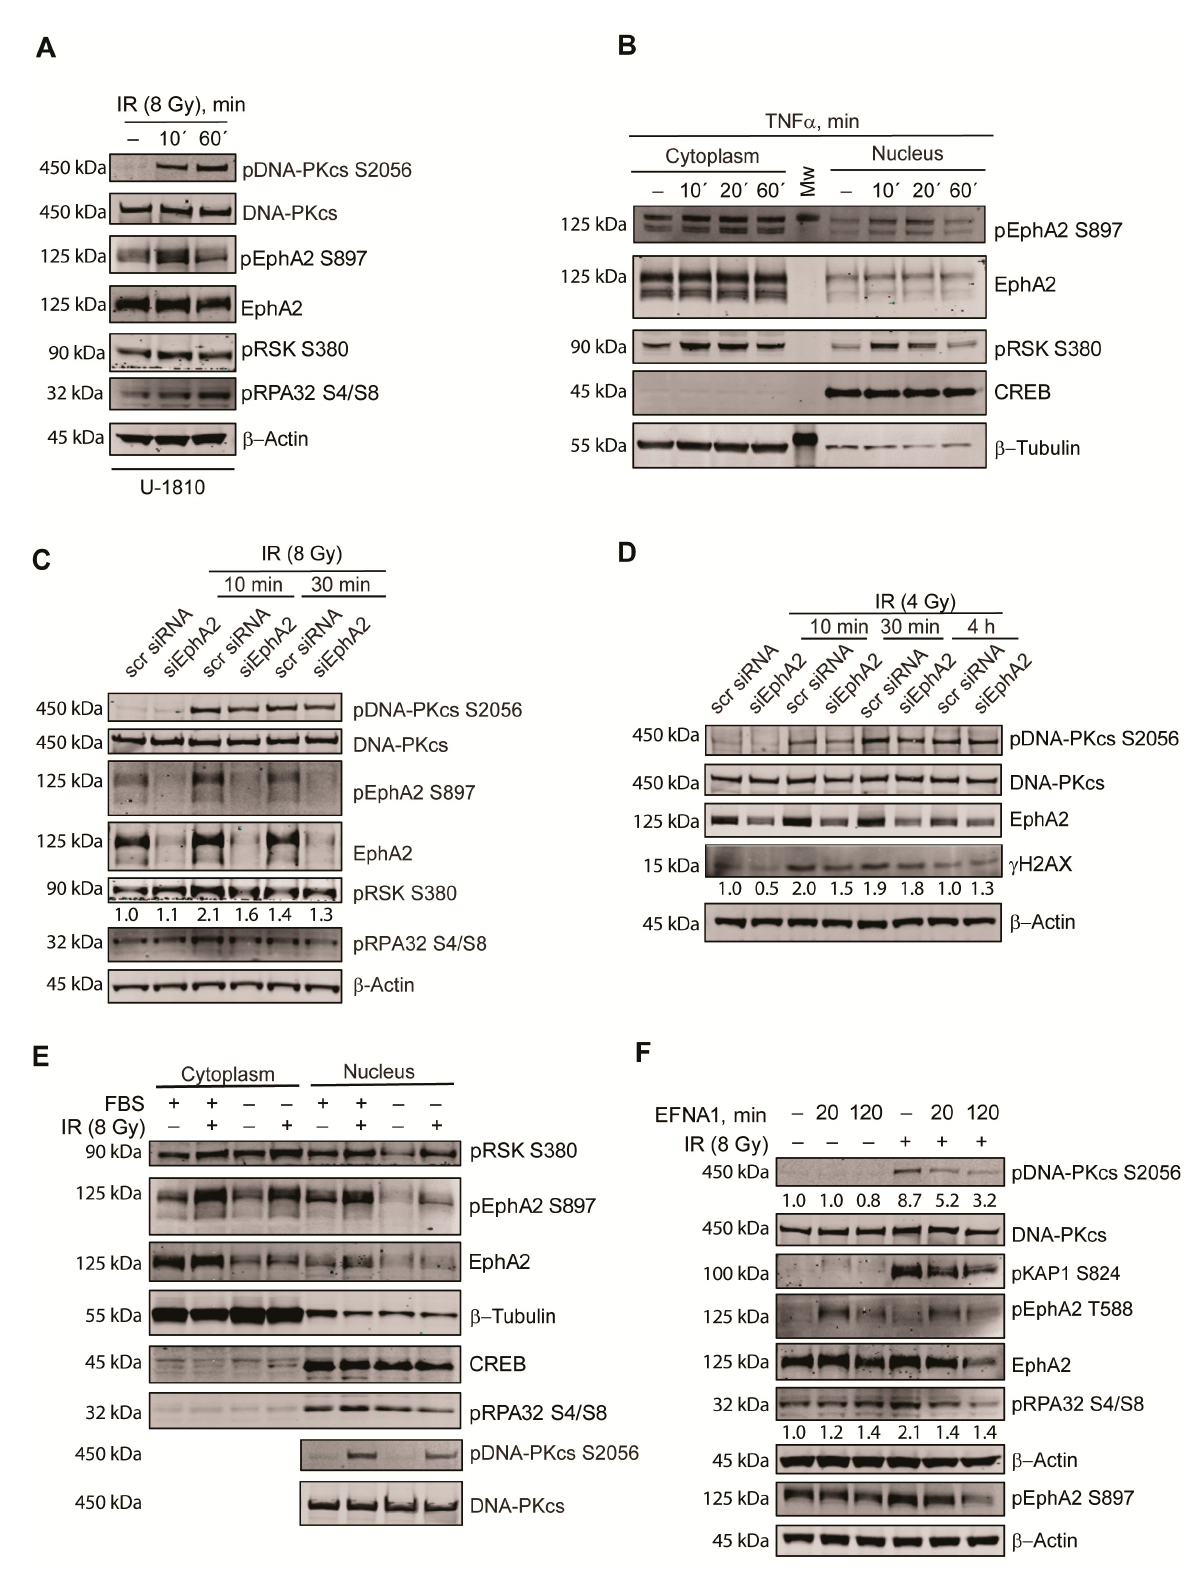
Figure 5. Modulation of EphA2 signaling affects DNA-PK responses. ( A ) U-1810 cells were irradiated (8 Gy) and 10- or with the total forms of DNA-PK cs and EphA2. β -Actin was used to control protein loading. ( B ) A549 cells were treated for indicated time with TNF α (20 ng/mL) and phosphorylation of EphA2 at S897, and RSK at S380 in cell fractions were analyzed by immunoblotting. β -Tubulin and CREB were used to control fraction loading. ( C ) Silencing of EphA2 was performed